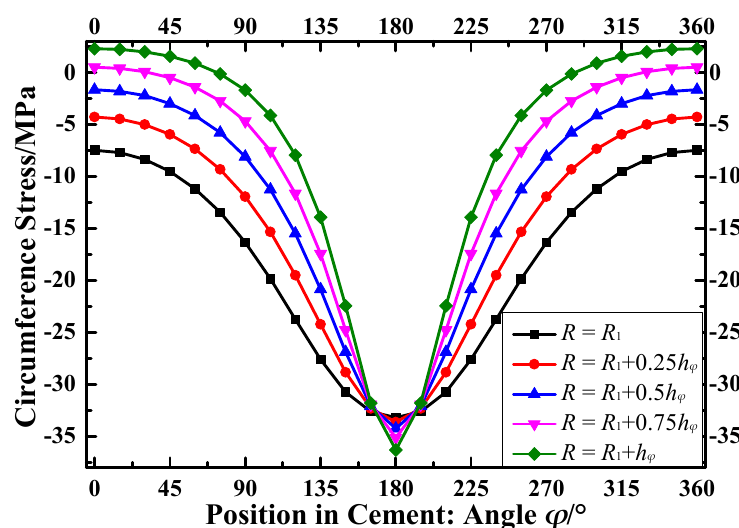
Figure 10. Variation of the circumferential stress in the cement sheath with the increase of azimuth angle φ at radius R.